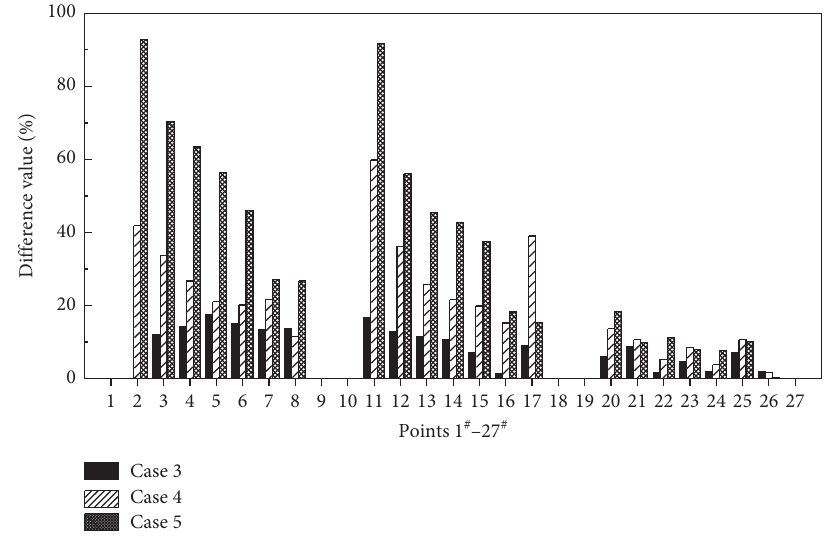
Figure 11: Relative difference of MFD in Cases 3, 4, and 5 (except for the support